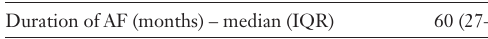
Patient characteristics (n =